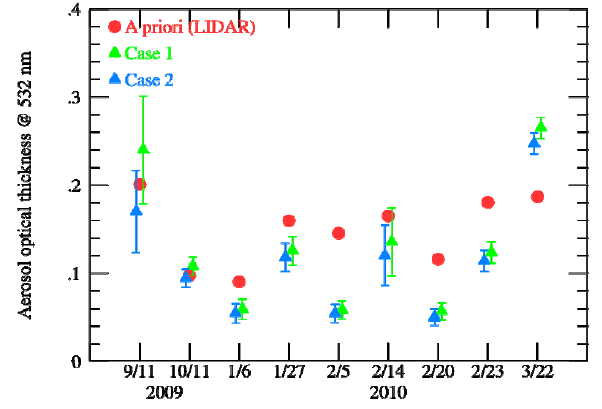
Fig. 6. Comparison of retrieved optical thickness at 532nm (Case 1 and Case 2) with a priori values estimated from lidar measurements. Fig. 6. The error bars of the retrieved values are also